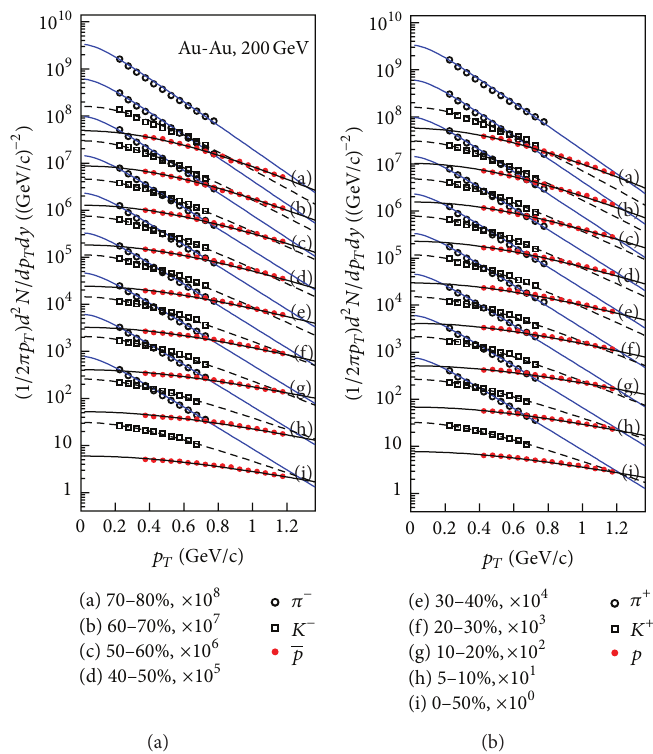
Figure 7: The same as for Figure 5, but showing the results at √ 𝑠 𝑁𝑁 = 200